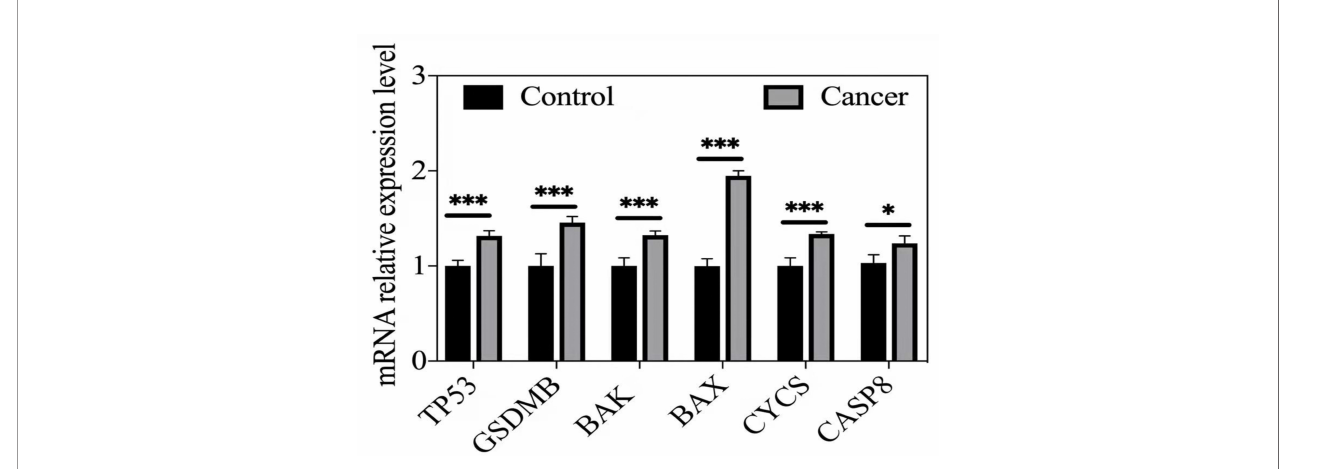
FIGURE 5 | qRT-PCR validation or hub DE-PRGs in human prostate cancer tissues compared to control tissues. *p < 0.05; ***p < 0.001. Cancer (n = 5-6), human prostate cancer tissues. Control (n = 5-6), matched human normal prostate